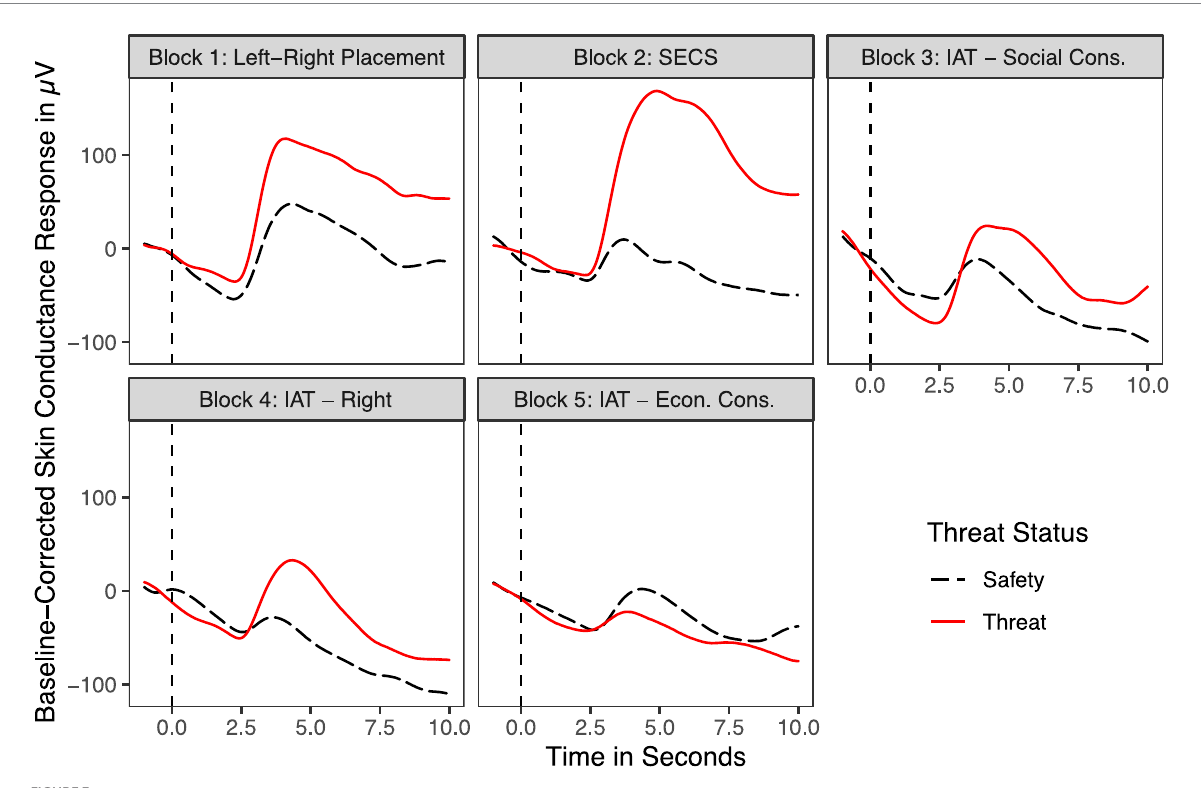
FIGURE 3 Mean baseline-corrected skin conductance levels per block for 10s after the onset of the threat and saftey phase. Averages are shown separately for experimental conditions. Participants under threat are indicated by red lines and participants under safety by black